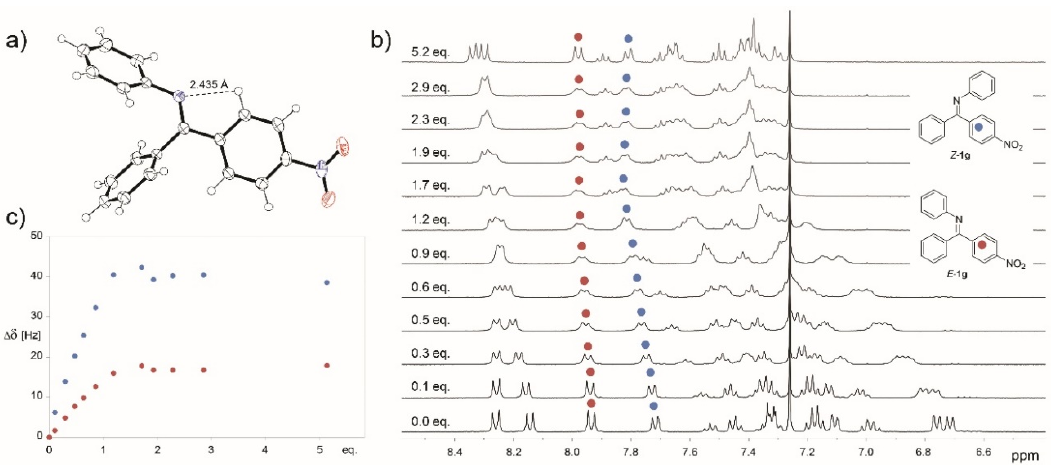
Figure 2. ORTEP projection of the crystal structure of E - 1g ( a ), 1 H NMR titration of 1g with HBF 4 ( b ), and the dependence of Δδ on the HBF 4 equivalents added ( c ).